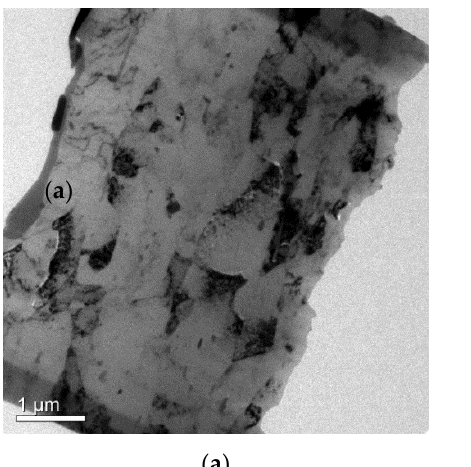
Figure 5. TEM micrograph of ( a ) as-forged RF50 and ( b ) as-forged HF50. After T73 treatment, dispersoids were produced in the over-aged conditions and